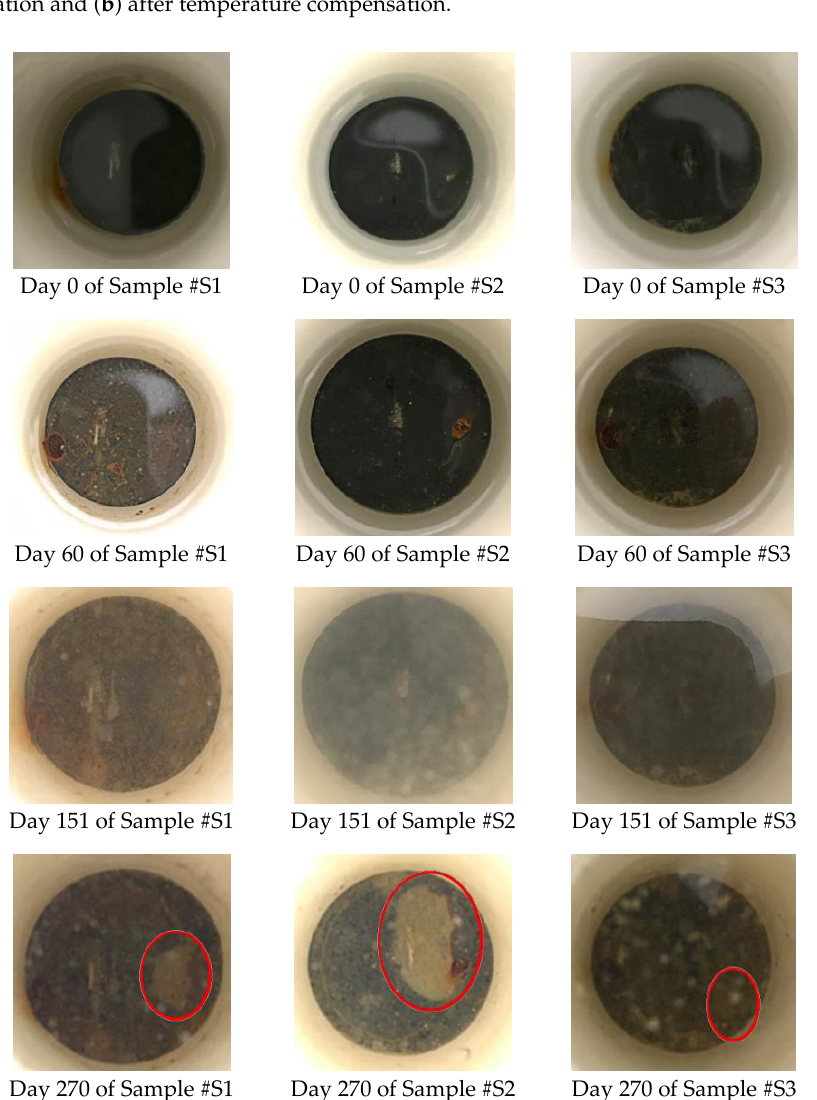
Figure 7. Visual Inspection of Samples #S1–S3.